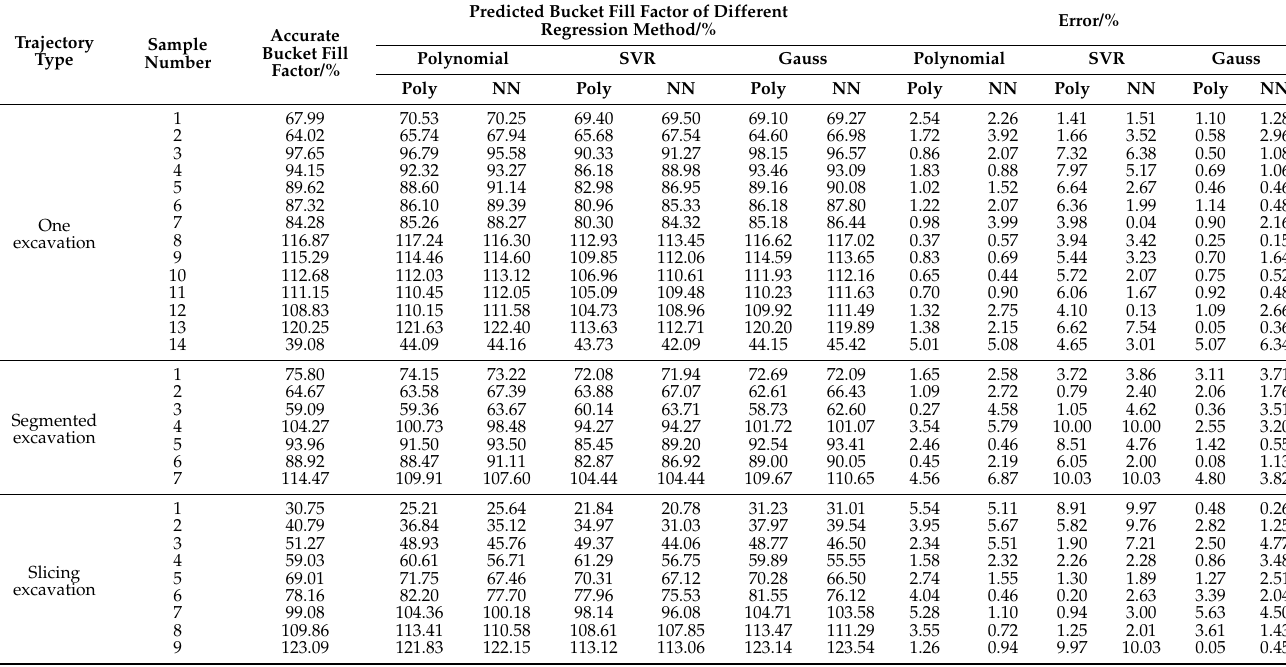
Table 5. Predicted results of bucket fill factor.